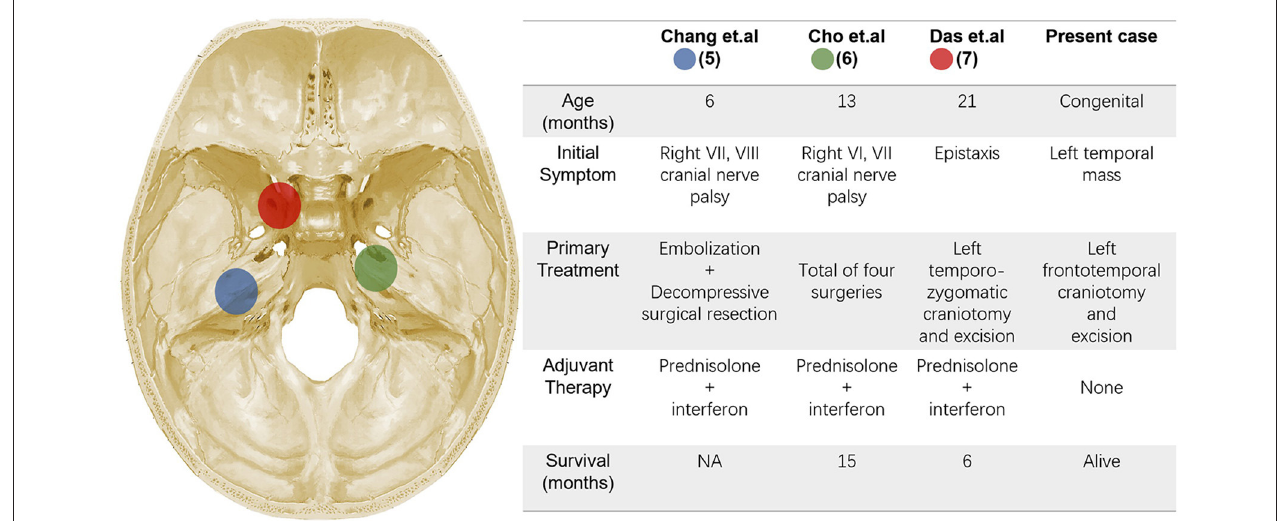
FIGURE 5 | The different colors indicate KHE lesions locations of the